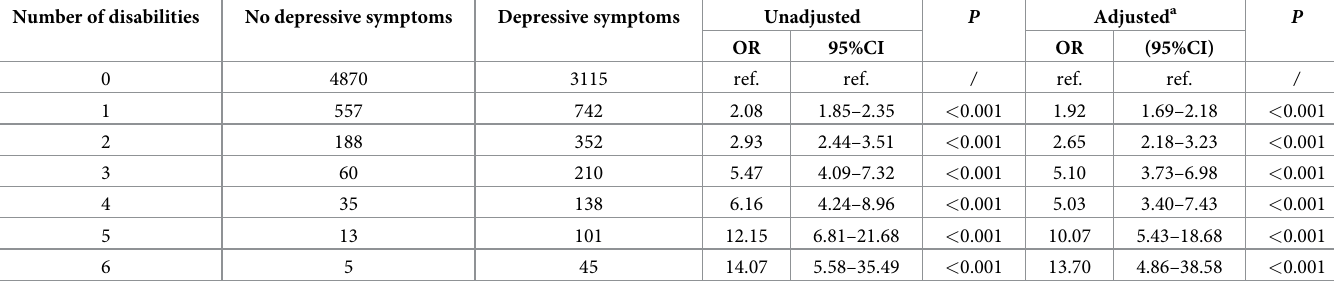
Table 4. Crude and adjusted odds ratios (OR) for the associations between quantity of self-care disability and depressive symptoms.